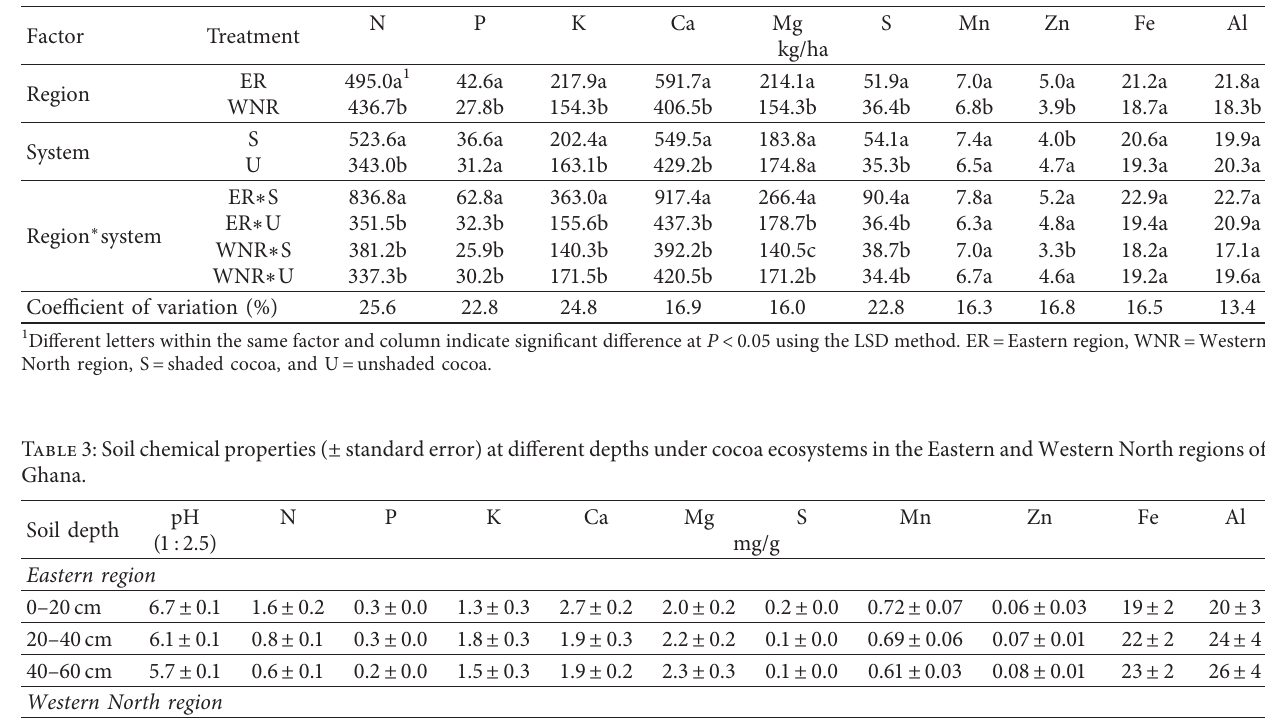
Table 2: Nutrient stocks in the biomass components (cocoa and shade trees, stumps, and floor litter) of cocoa ecosystems ( n � 3). Factor Treatment Region